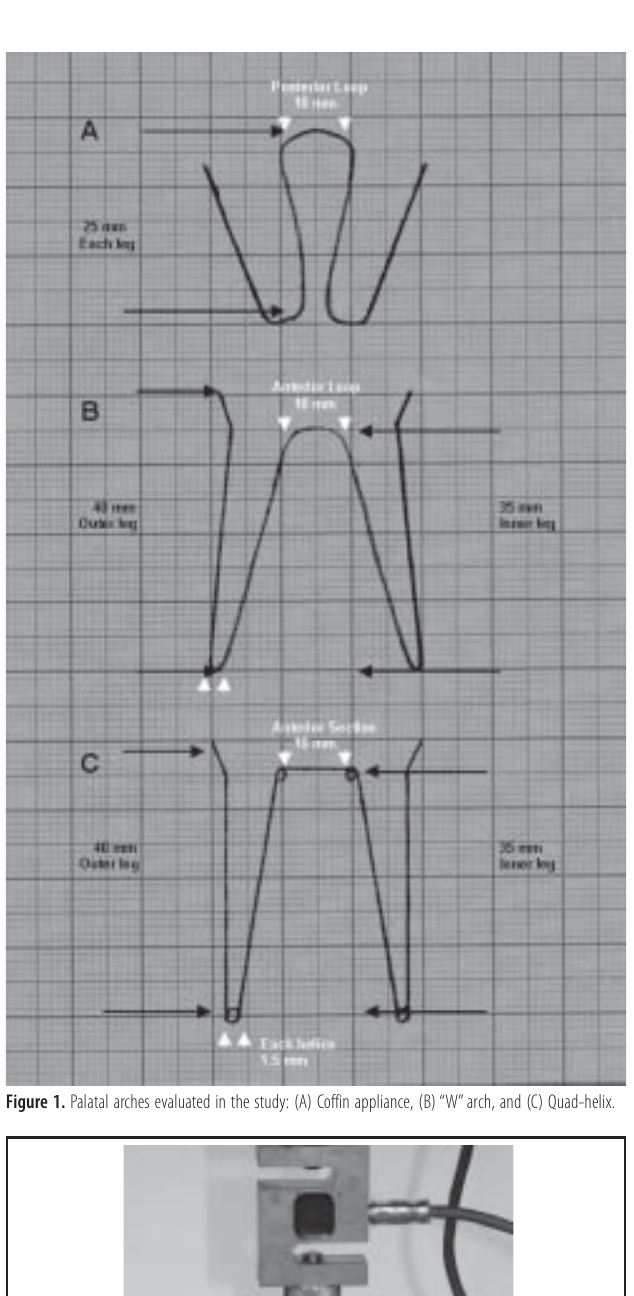
Figure 1. Palatal arches evaluated in the study: (A) Coffin appliance, (B) “W” arch, and (C) Quad-helix.